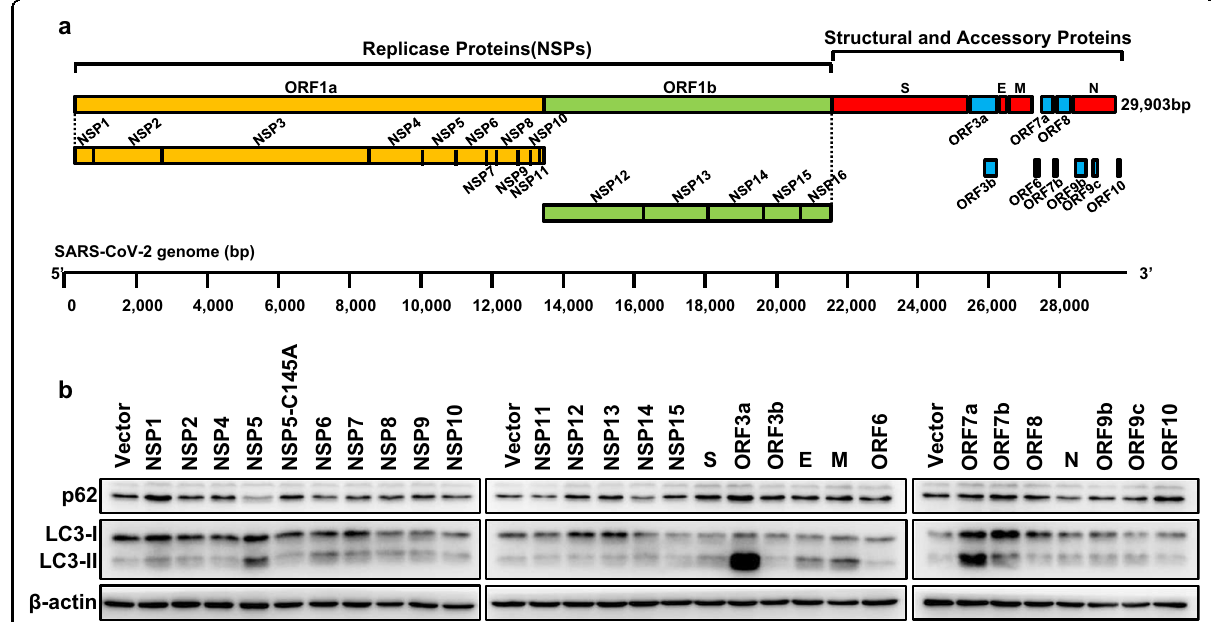
Fig. 1 Global analysis of SARS-CoV-2-encoded proteins in autophagy. a Annotation of the SARS-CoV-2 genome and encoded proteins. b Screening of SARS-CoV-2-encoded proteins for the regulation of autophagy in HEK293T cells by determining the protein levels of p62 (substrate receptor) and LC3-II (autophagosome marker protein), which are both degraded by